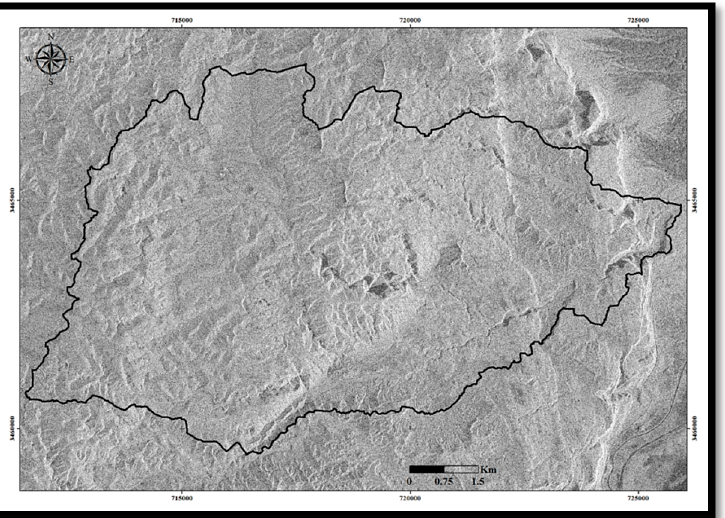
Figure 2. Constellation of small satellites for Mediterranean basin observation (COSMO)-SkyMed synthetic aperture radar (SAR) image of Rahaf basin. Because most of the radar’s energy is reflected away from smooth surfaces, the tone of these surfaces in the image will appear dark, while lighter image tones are caused by the backscatter energy from rougher surfaces back to the antenna [44].